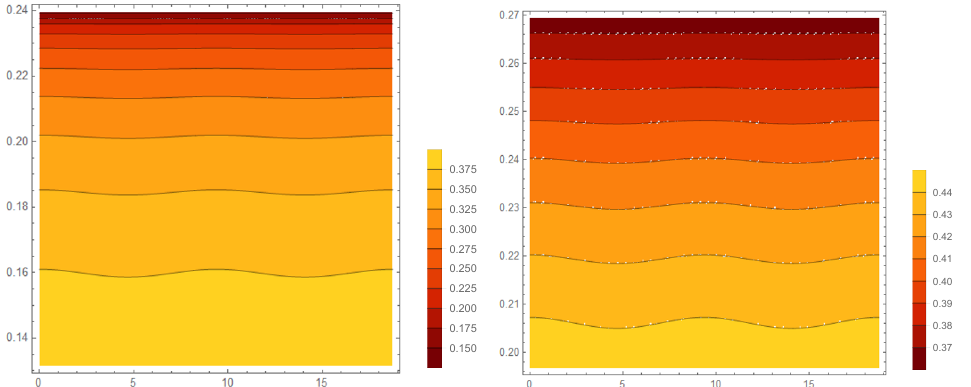
Figure 11 . The contour plot for the condensate η 2 ( x ) as a function of x and temperature T for x = 1 . 5 and x = 1 . 6 ,